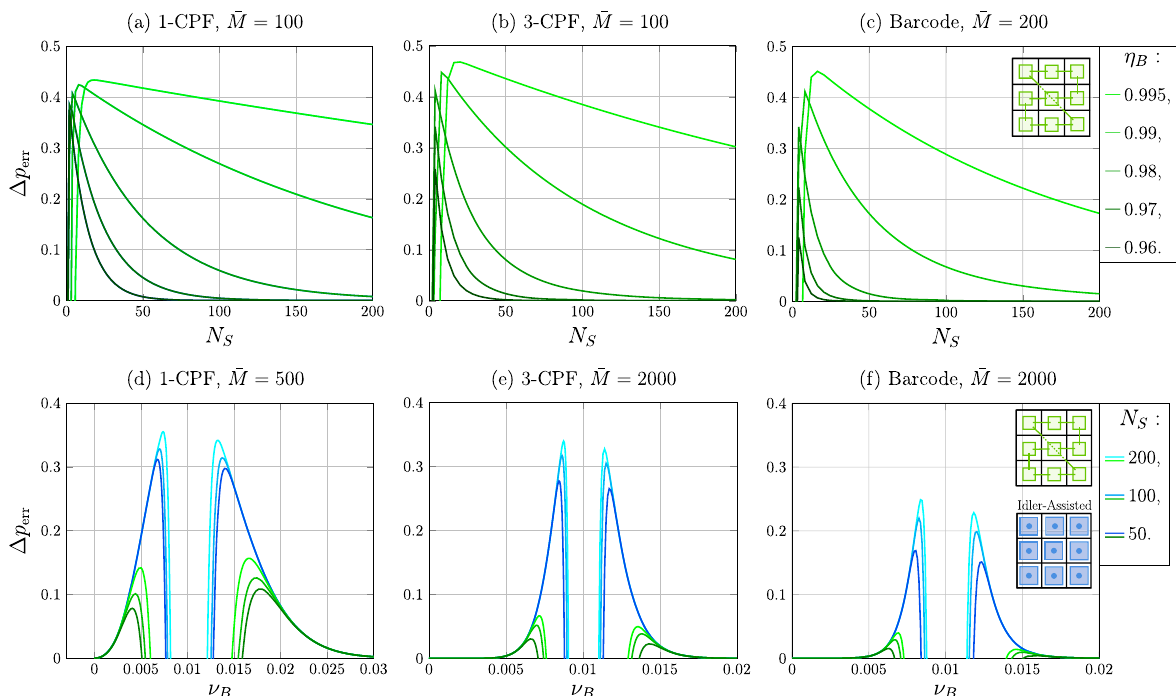
Fig. 5 Guaranteed quantum advantage. As per Eq. (23), for 9-pixel a , d CPF, b , e 3-CPF and c , f full image space (barcode) discrimination using the nearest-neighbour dynamic protocol compared with full idler assistance. In a – c , the m = 9 pure-loss channels are considered, with target pixel transmissivity η T = 1 and various background transmissivities η B , plotted against signal energy N S . Here the difference in advantage with the idler-assisted protocol is too small to be plotted. Panels d – f study additive noise m = 9 channel patterns for target noise ν T = 0.01 and various signal energies, plotted against background noise ν B